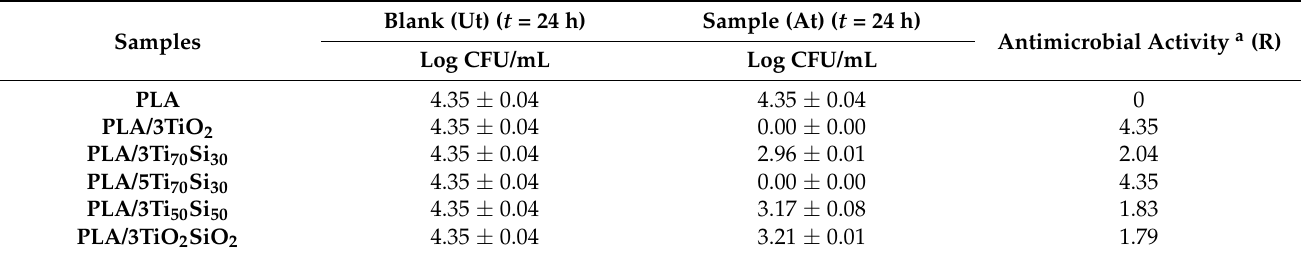
Table 7. Antimicrobial activity of Gram-positive bacteria ( Staphylococcus aureus ) of PLA, PLA/TiO 2 , PLA/Ti x Si y , and PLA/TiO 2 SiO 2 composites.